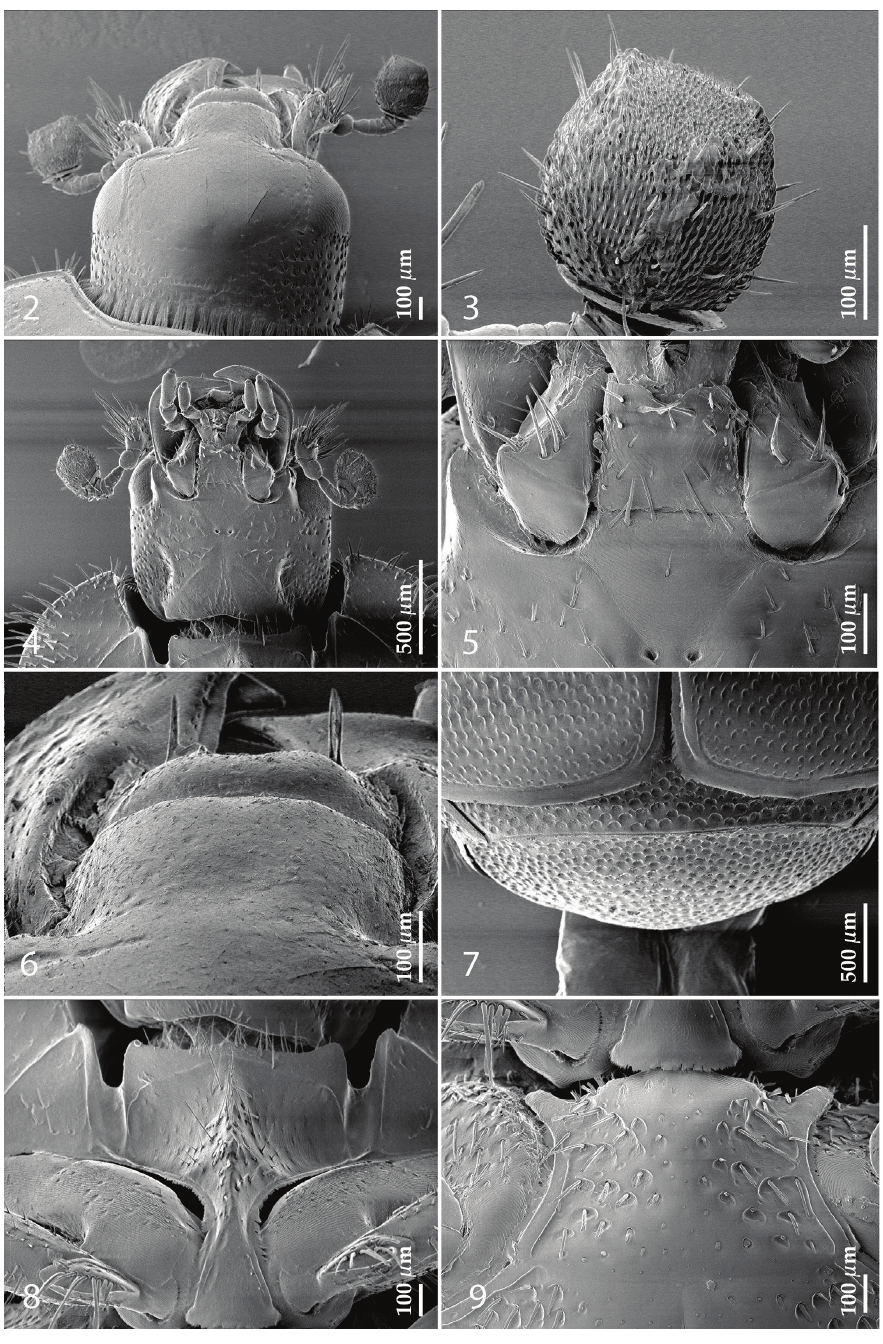
Figures 2–9. 2 Australopachylopus lepidulus (Broun, 1881) comb. n., head, dorsal view 3 antennal club, dorsal view 4 head, ventral view 5 mentum, ventral view 6 labrum + clypeus, dorsal view 7 propygidium + pygidium 8 prosternum 9